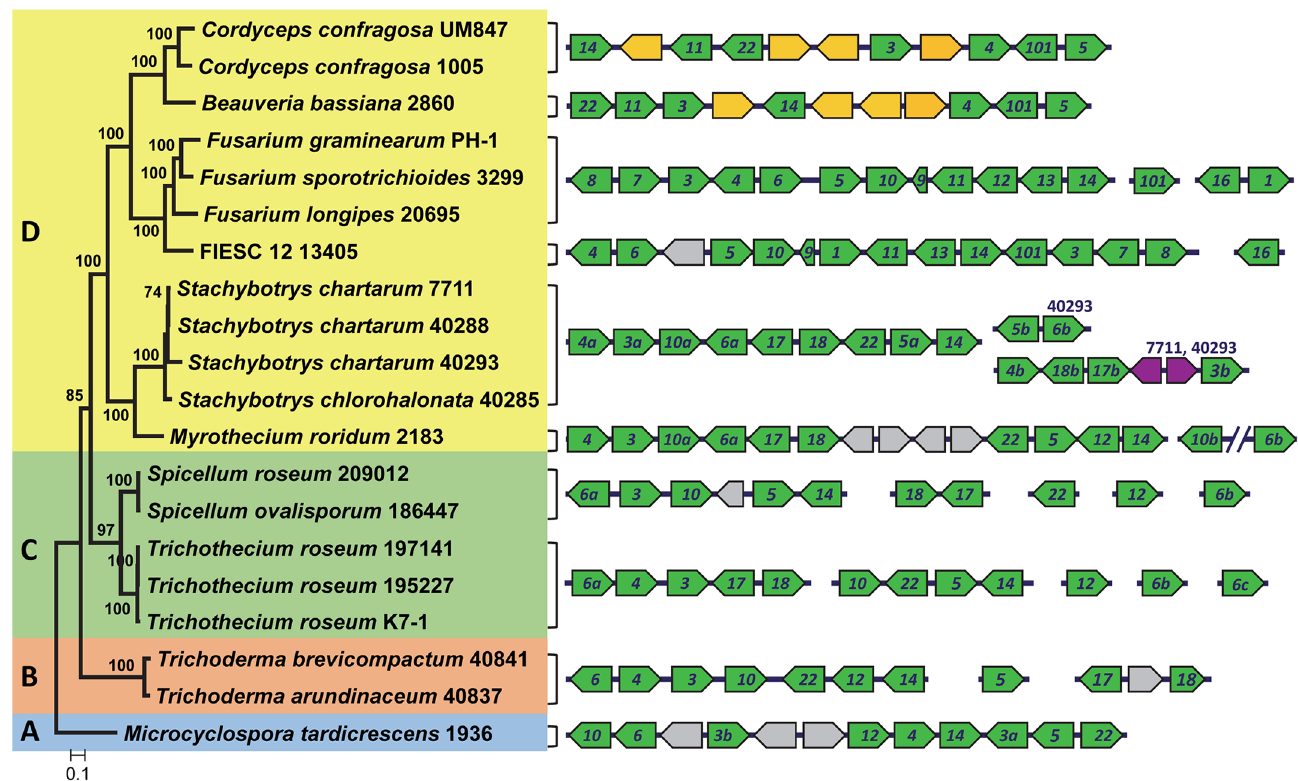
Fig 3. Gene content and arrangement at TRI loci in fungi examined in this study. The phylogenetic tree to the left was inferred by maximum likelihood analysis of concatenated nucleotide sequences of TRI3 , TRI5 ,and TRI14 ,the only three TRI genes common to all the fungi. Numbers near branch nodes are bootstrap values based on 1000 pseudoreplicates. The four colored blocks (labeled A, B, C and D) indicate four lineages of TRI genes. The diagrams to the right show the content and arrangement of genes at TRI loci. Green arrows represent homologs of previously described TRI genes, and numbers within arrows indicate TRI gene designations (e.g., 14 indicates TRI14 ). TRI22 was originally described as TRI11 in Trichoderma , but here we consider TRI11 and TRI22 to be functionally and phylogenetically distinct genes (S1 Fig). For the purposes of this study, paralogs are indicated by the lowercase letters a , b , and c ; e.g., TRI6 paralogs are indicated as 6a , 6b , and 6c .Gray arrows represent genes present in the TRI cluster of only one genus; orange arrows represent genes unique to Beauveria and Cordyceps ; and purple arrows represent genes unique to Stachybotrys and Myrothecium (S2 Fig). Arrows overlaid on the same line indicate genes on the same contig, whereas arrows overlaid on different lines indicate genes on different contigs. For Stachybotrys , the numbers 7711 and 40293 above TRI paralogs indicate strains in which the paralogs occur. TRI3b in S . chartarum strain 40293 is truncated relative to other TRI3 homologs and, as a result, is likely nonfunctional.